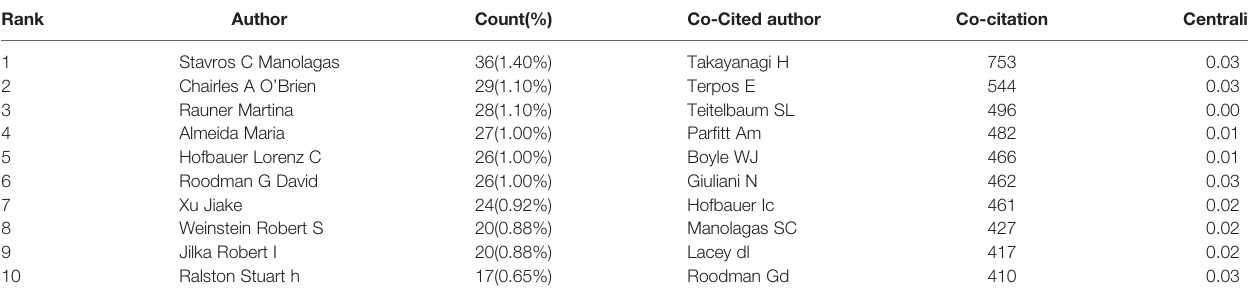
TABLE 4 | The top 10 authors and co-cited authors of osteoblasts-osteoclasts in bone disease research.